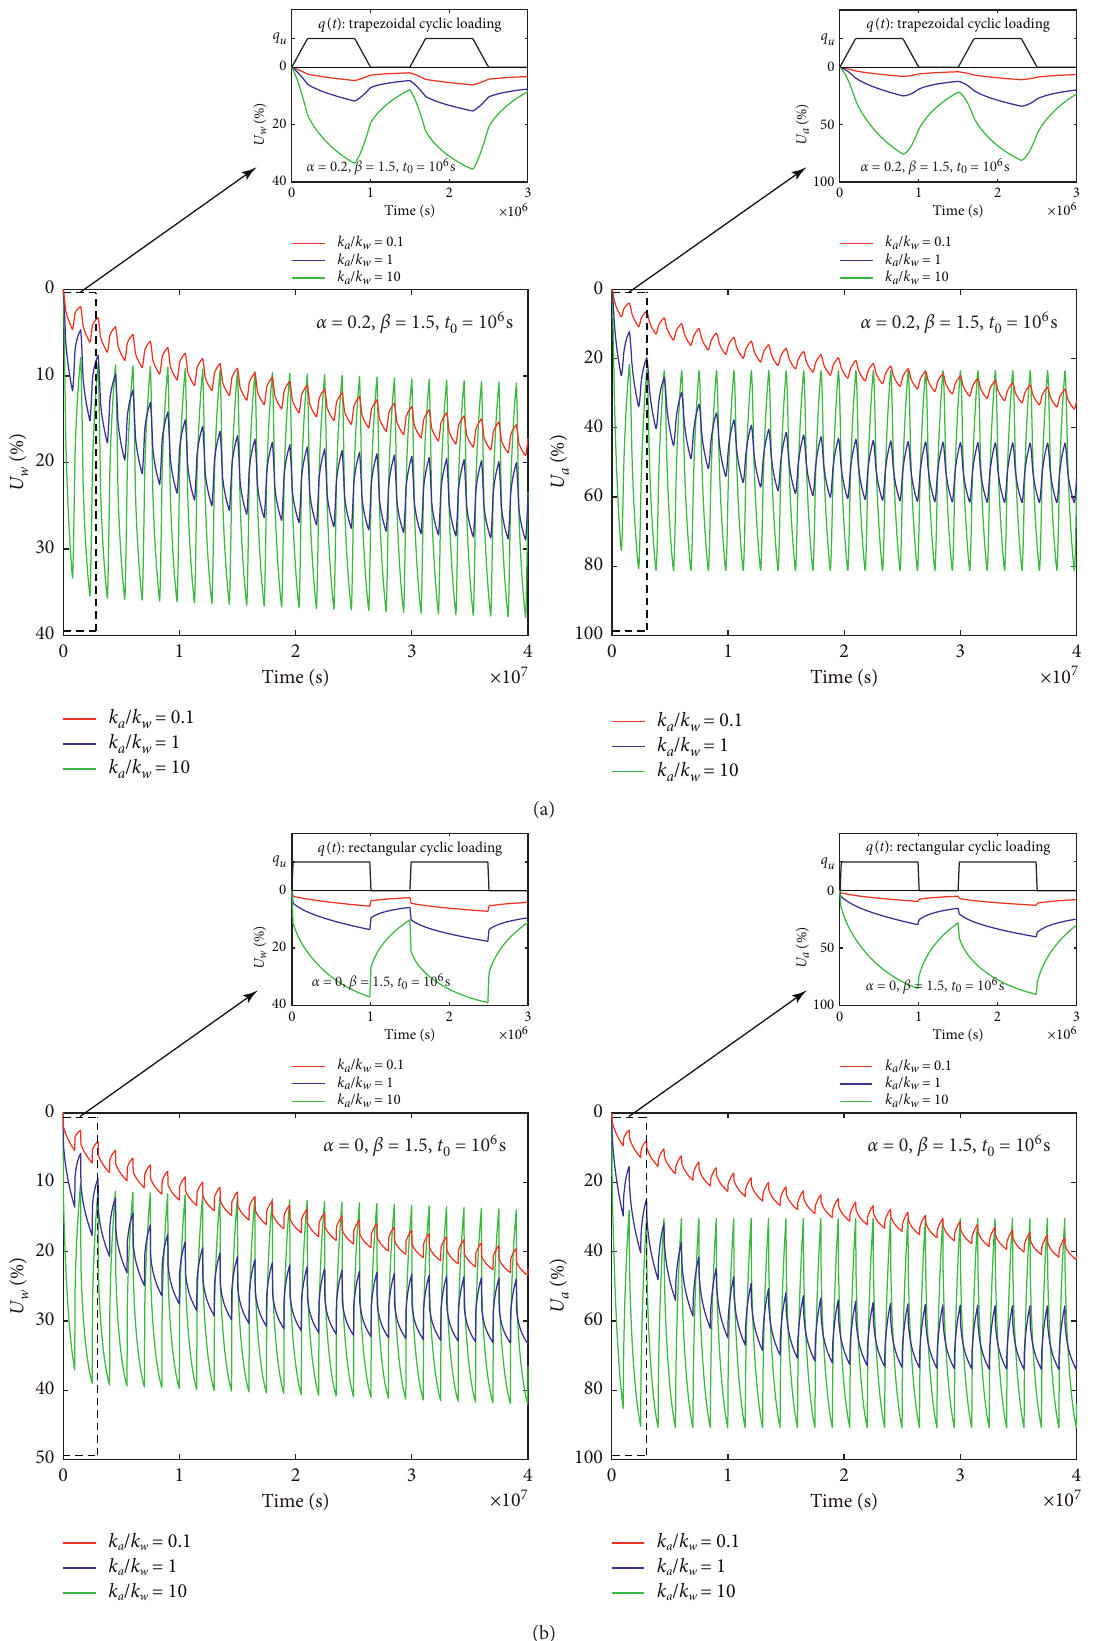
Figure 7: The effects of k k a / w on consolidation of unsaturated soils under trapezoidal cyclic loading (a) and rectangular cyclic loading (b).